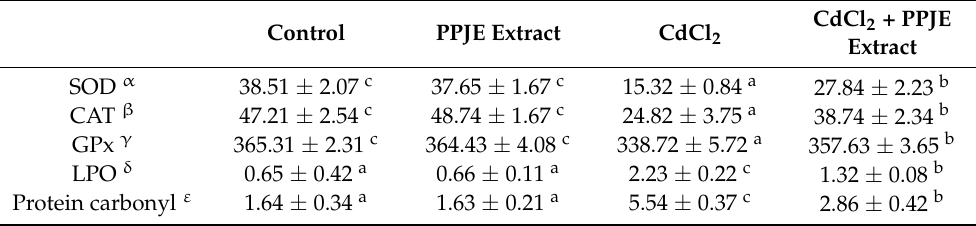
Table 6. Antioxidant enzyme activities and stress biomarkers levels in testicular tissue of the studied groups. Control rats. PPJE extract (250 mg/kg)-treated rats. CdCl 2 (1 mg/kg)-treated rats. CdCl 2 + PPJE extract (250 mg/kg)-treated rats. α : U mg − 1 protein; β : µ moles/H 2 O 2 consumed min − 1 mg − 1 of protein; γ : nmoles GSH min − 1 mg − 1 of protein; δ : nmoles of MDA g − 1 of tissue; ε : nmoles mg − 1 of